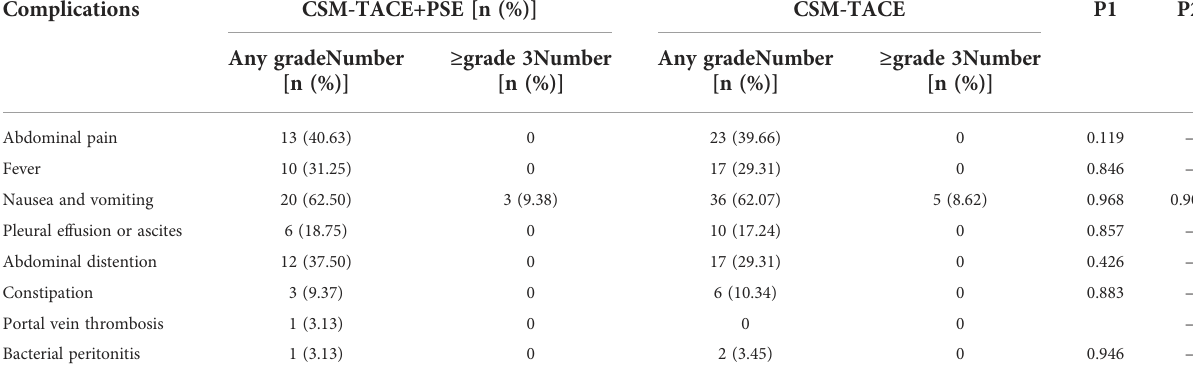
TABLE 12 Complications observed in 90 patients at 1 week after surgery.